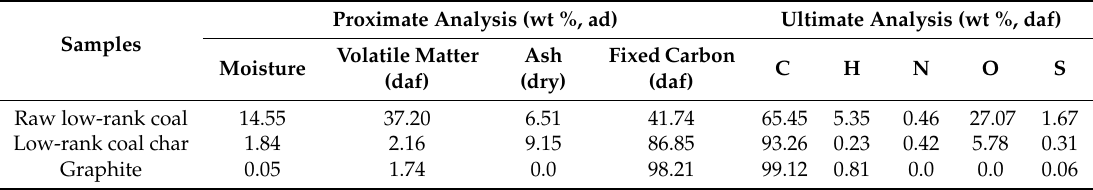
Figure 1. Figure 1. Scanning electron microscopy images of samples for oxygen-enriched combustion: ( a ) raw coal, ( b ) char, and ( c ) graphite. Table 1. Proximate and ultimate analyses of Table 1. Proximate and ultimate analyses of samples.